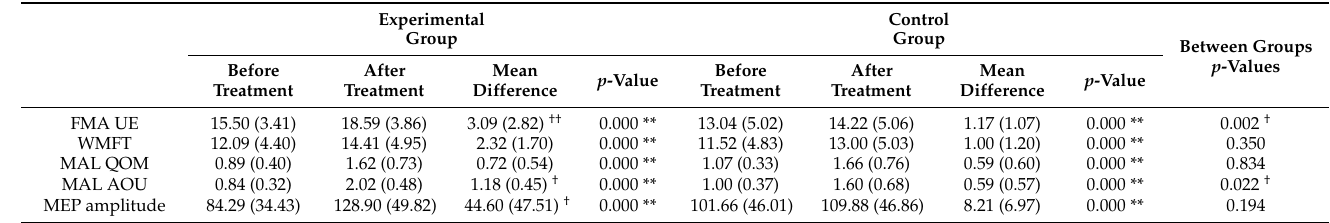
Table 2. Comparison of results between the experimental group and control